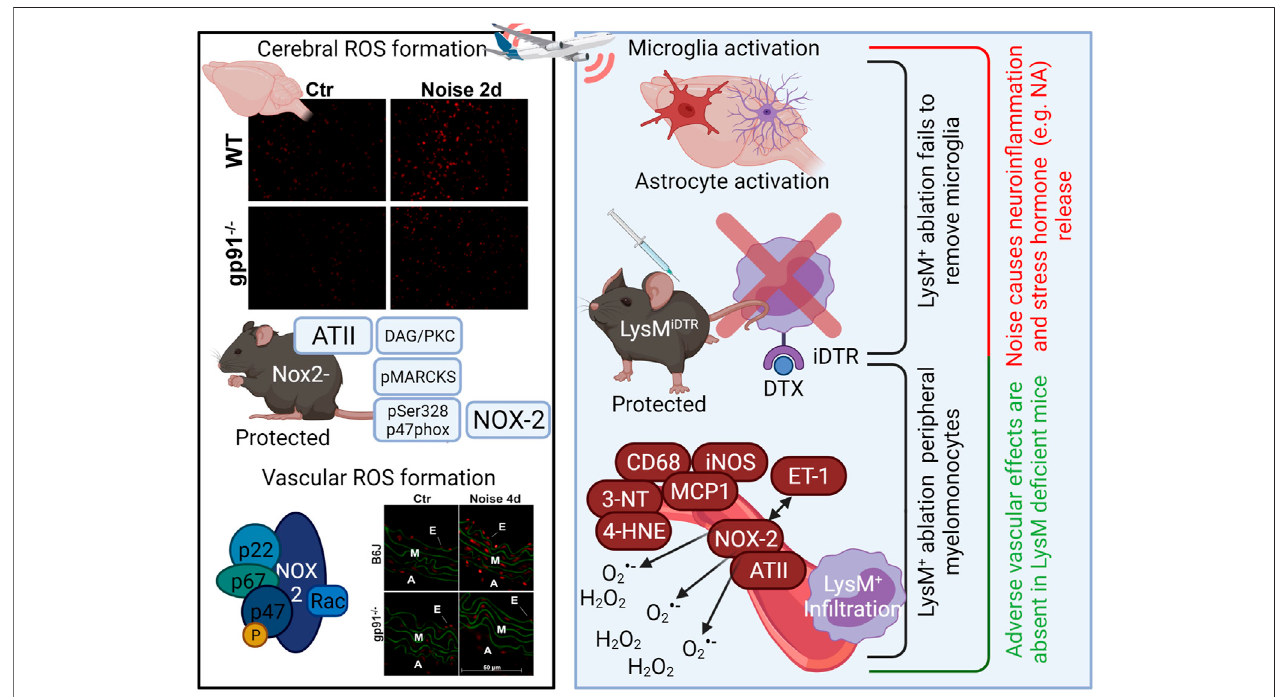
FIGURE2| ActivationofthephagocyticNADPHoxidase(Nox2,gp91phox)bynoise(Kroller-Schonetal.,2018)androleofLysM-positivemyelomonocyticcellsfor noise-induced cardiovascular in fl ammation and damage (Frenis et al., 2021). Noise causes cerebral and vascular ROS formation as envisaged by more pronounced dihydroethidium (DHE)-derived red fl uorescence in cerebral and aortic cryo-sections that was partially corrected in gp91phox (Nox2) knockout mice (representative stainings).Nox2activationbynoisewasprobablybasedonangiotensin-II(ATII)-dependentAT1-receptoractivationwithsubsequentactivationofphospholipaseC and diacylglycerol (DAG) formation, a strong protein kinase C (PKC) activator. PKC activation was documented by noise-triggered phosphorylation of the PKC target myristoylated, alanine-rich C kinase substrate (MARCKS) as well as phosphorylation of p47phox at serine 328, a regulatory cytosolic subunit of Nox2. Translocation of pSer328-p47phox, among other cytosolic regulators, to the cytoplasmatic membrane-bound gp91phox leads to full activation of Nox2 and subsequent superoxide formation. Genetic ablation by treatment of mice with LysM-positive cell (myelomonocytic) speci fi c overexpression of an inducible diphtheria toxin receptor (LysM iDTR ) withlowdosediphtheriatoxin(Wenzeletal.,2011).MicefreeofLysM-positivecellsshowednonoise-dependentin fi ltrationofmonocytes,macrophagesorgranulocytes and preserved endothelial function, normal blood pressure and no aortic oxidative stress indicating that LysM-positive cell ablation protects the periphery from noise- induceddamage.Incontrast,microgliainthebrainofLysM iDTR micewerenotablatedbydiphtheriatoxinandnoise-inducedneuroin fl ammation,cerebraloxidativestress and release of stress hormones was not prevented. Image was created using Biorender.com. DHE staining images were reused from (Kroller-Schon et al., 2018) with